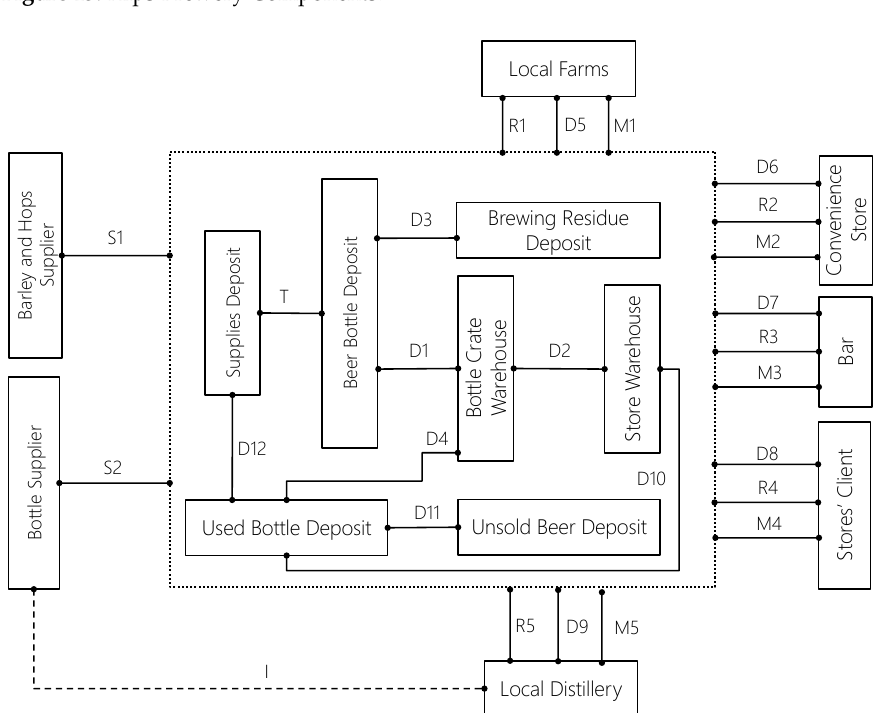
5. CASO DE ESTUDIO PARA ILUSTRAR TODO View: Beer View Figure 13. Alps Brewery Components.